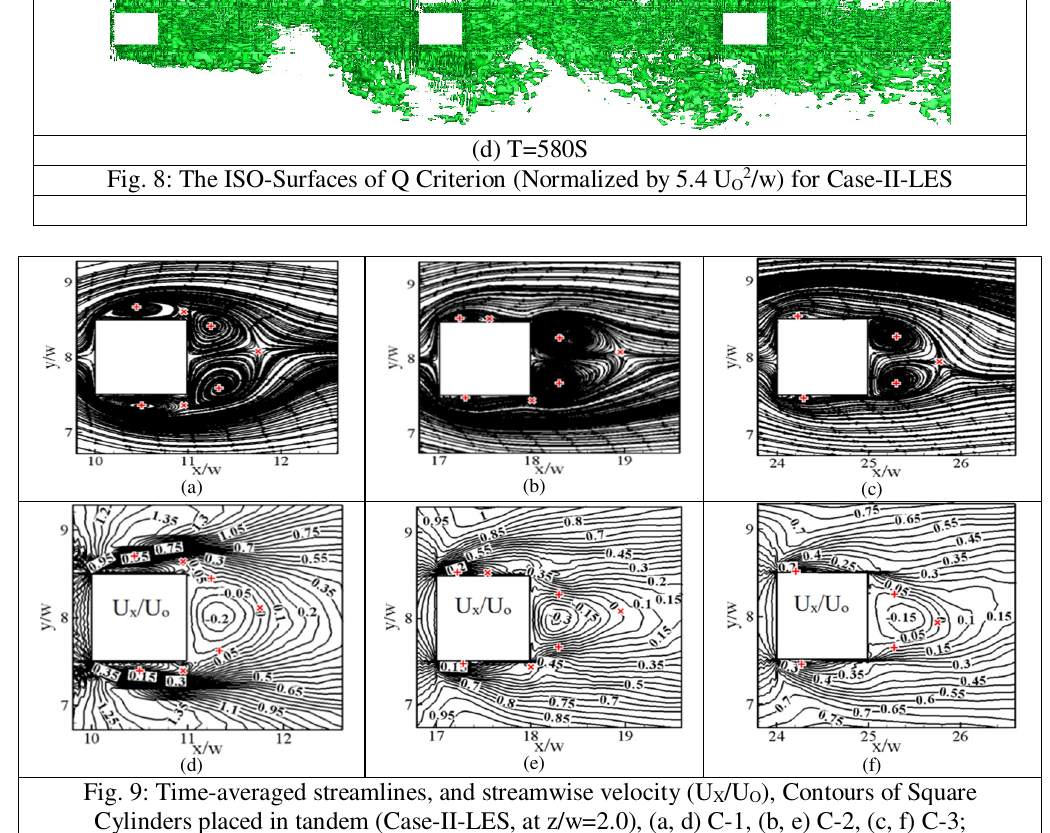
Fig. 9: Time-averaged streamlines, and streamwise velocity (U X /U O ), Contours of Square Cylinders placed in tandem (Case-II-LES, at z/w=2.0), (a, d) C-1, (b, e) C-2, (c, f) C-3; (Here, + represent centre, and × represent